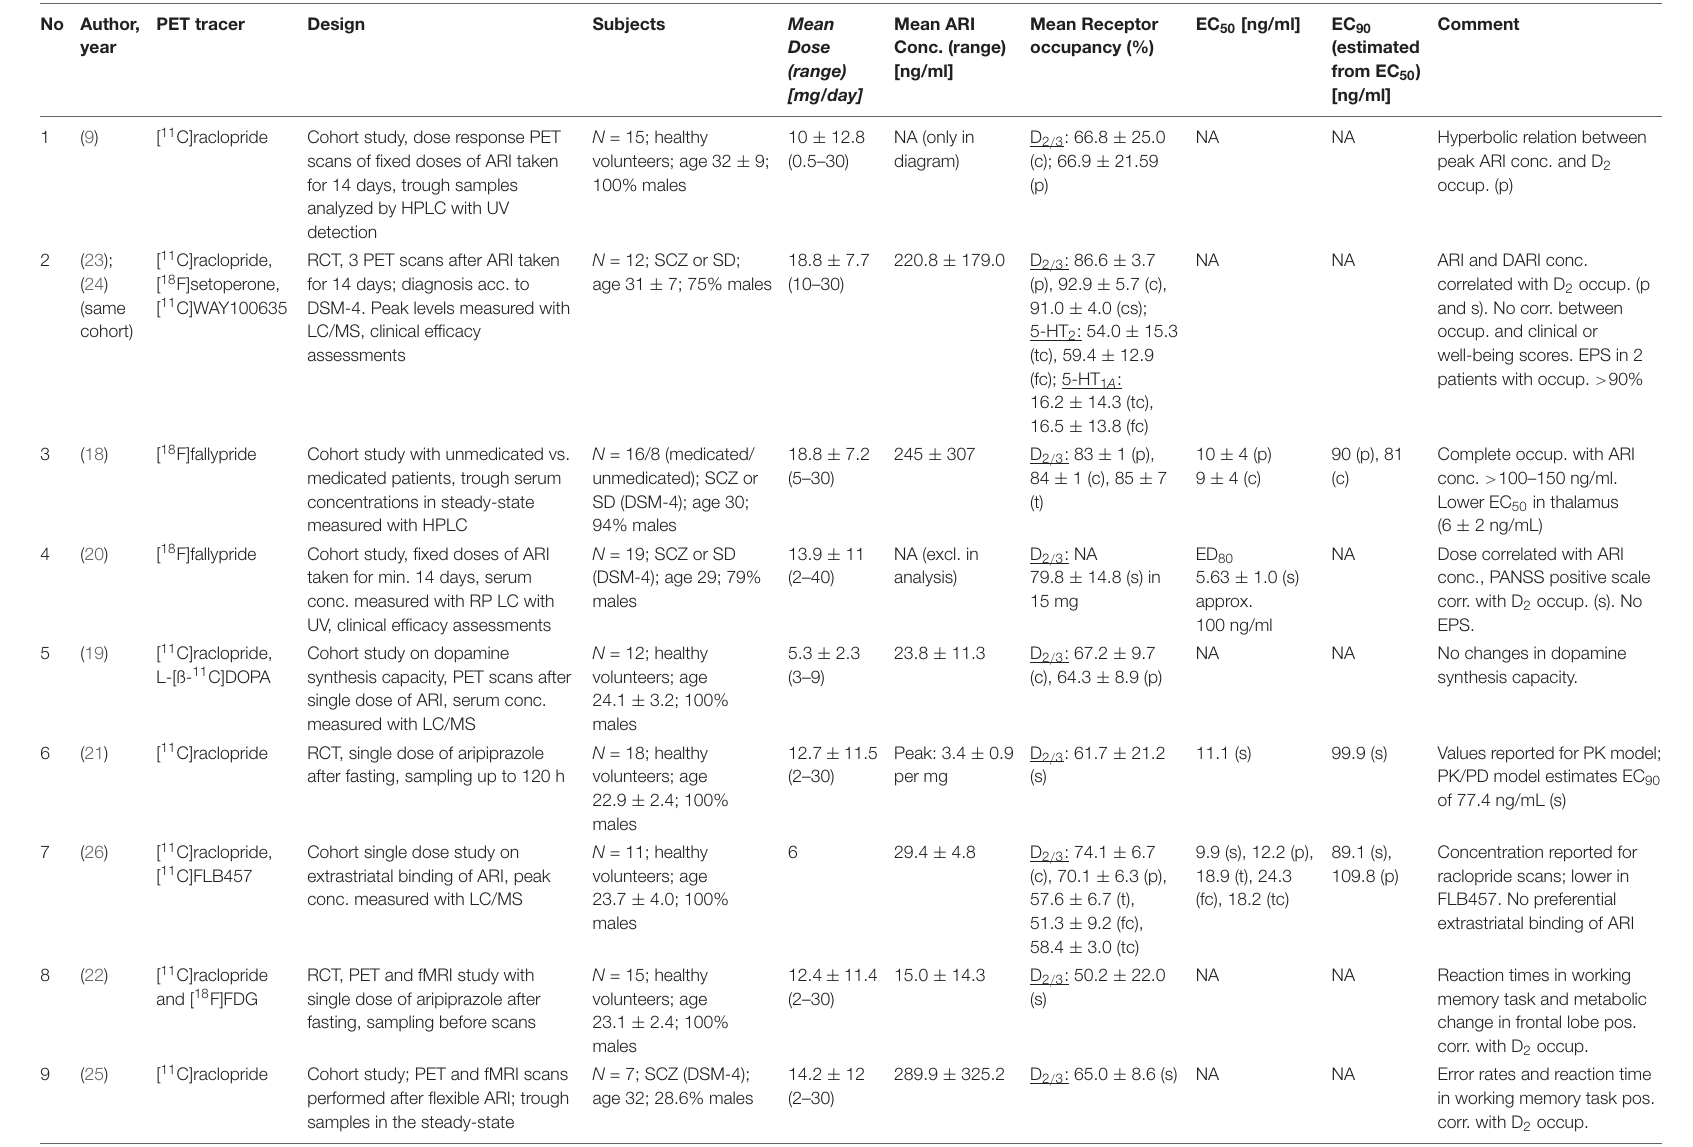
TABLE 1 | PET studies reporting D 2 receptor occupancy and aripiprazole (ARI) blood concentrations. No Author, PET year